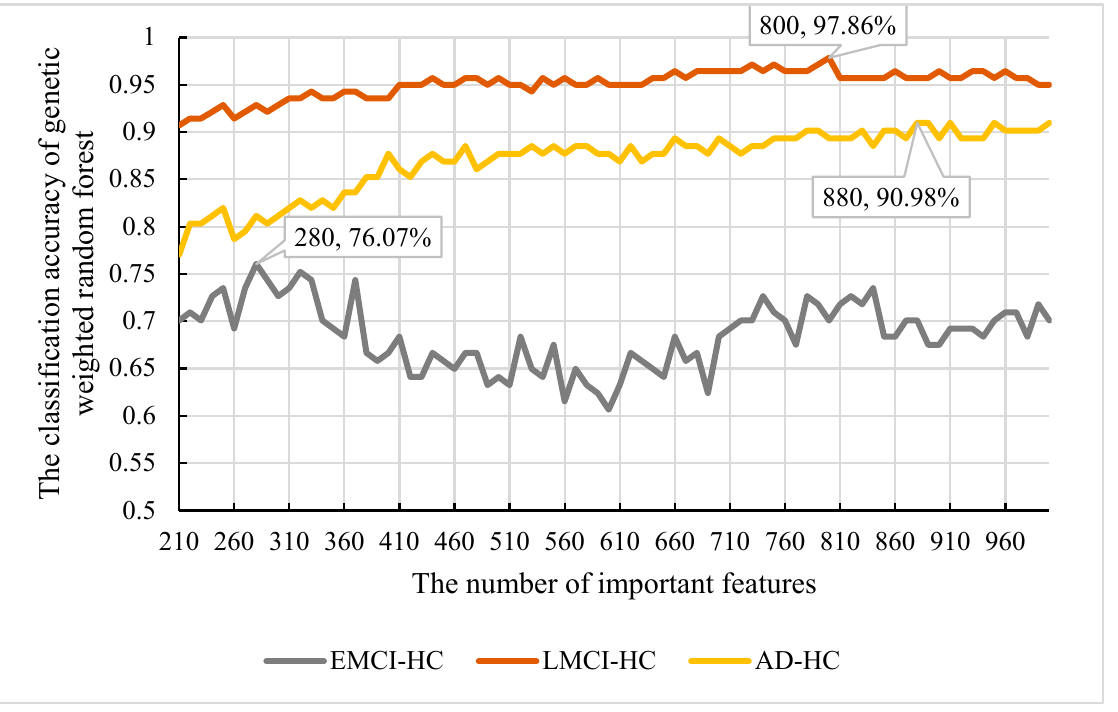
Figure 11. The classification accuracy and important features in (cid:2175) (cid:2157)(cid:2160)(cid:2879)(cid:2164)(cid:2159) , (cid:2175) (cid:2168)(cid:2169)(cid:2159)(cid:2165)(cid:2879)(cid:2164)(cid:2159) and (cid:2175) (cid:2161)(cid:2169)(cid:2159)(cid:2165)(cid:2879)(cid:2164)(cid:2159) .